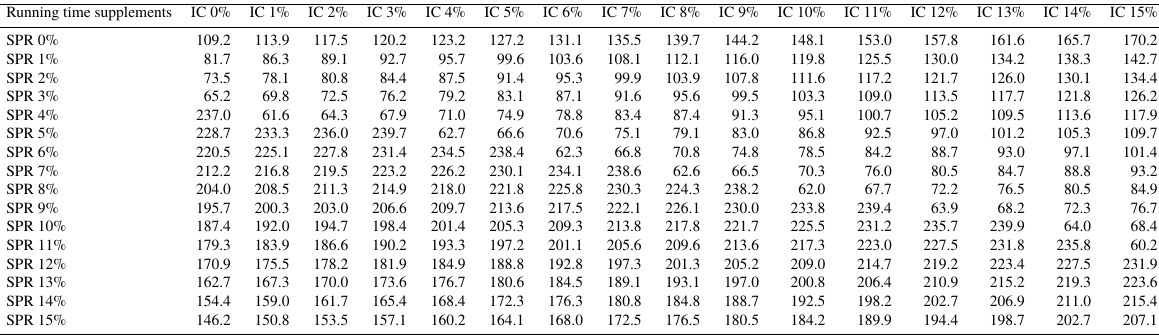
Table 13: Total buffer time (s) including the minimum buffer time (60 s) per IC-SPR cycle for different running time supplements for the real-world case study Ah-Nm. Note that the drop in the buffer time is caused by the frequency increase of the IC-SPR cycle (from 4 to 5 trains per hour).